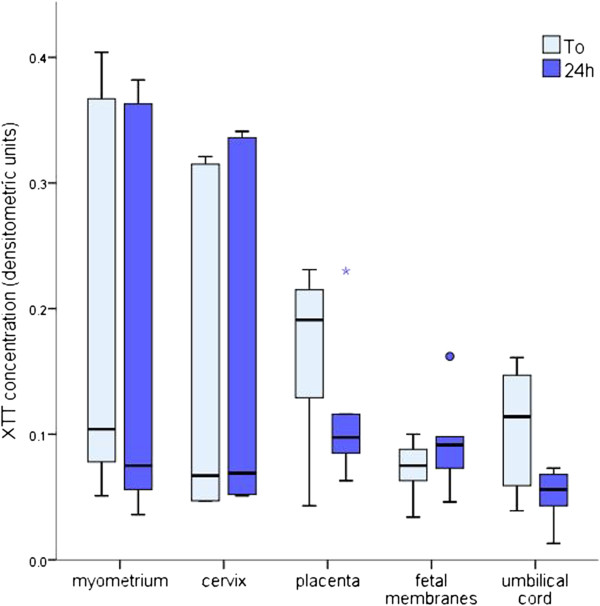
Viability of reproductive tissues during culture. The values represent median densitometric units with interquartile ranges. Outlier values are represented by circles and asterisks. No differences were found in the viability of any tissue comparing 0 h and 24 h with the Wilcoxon test (P > 0.05).